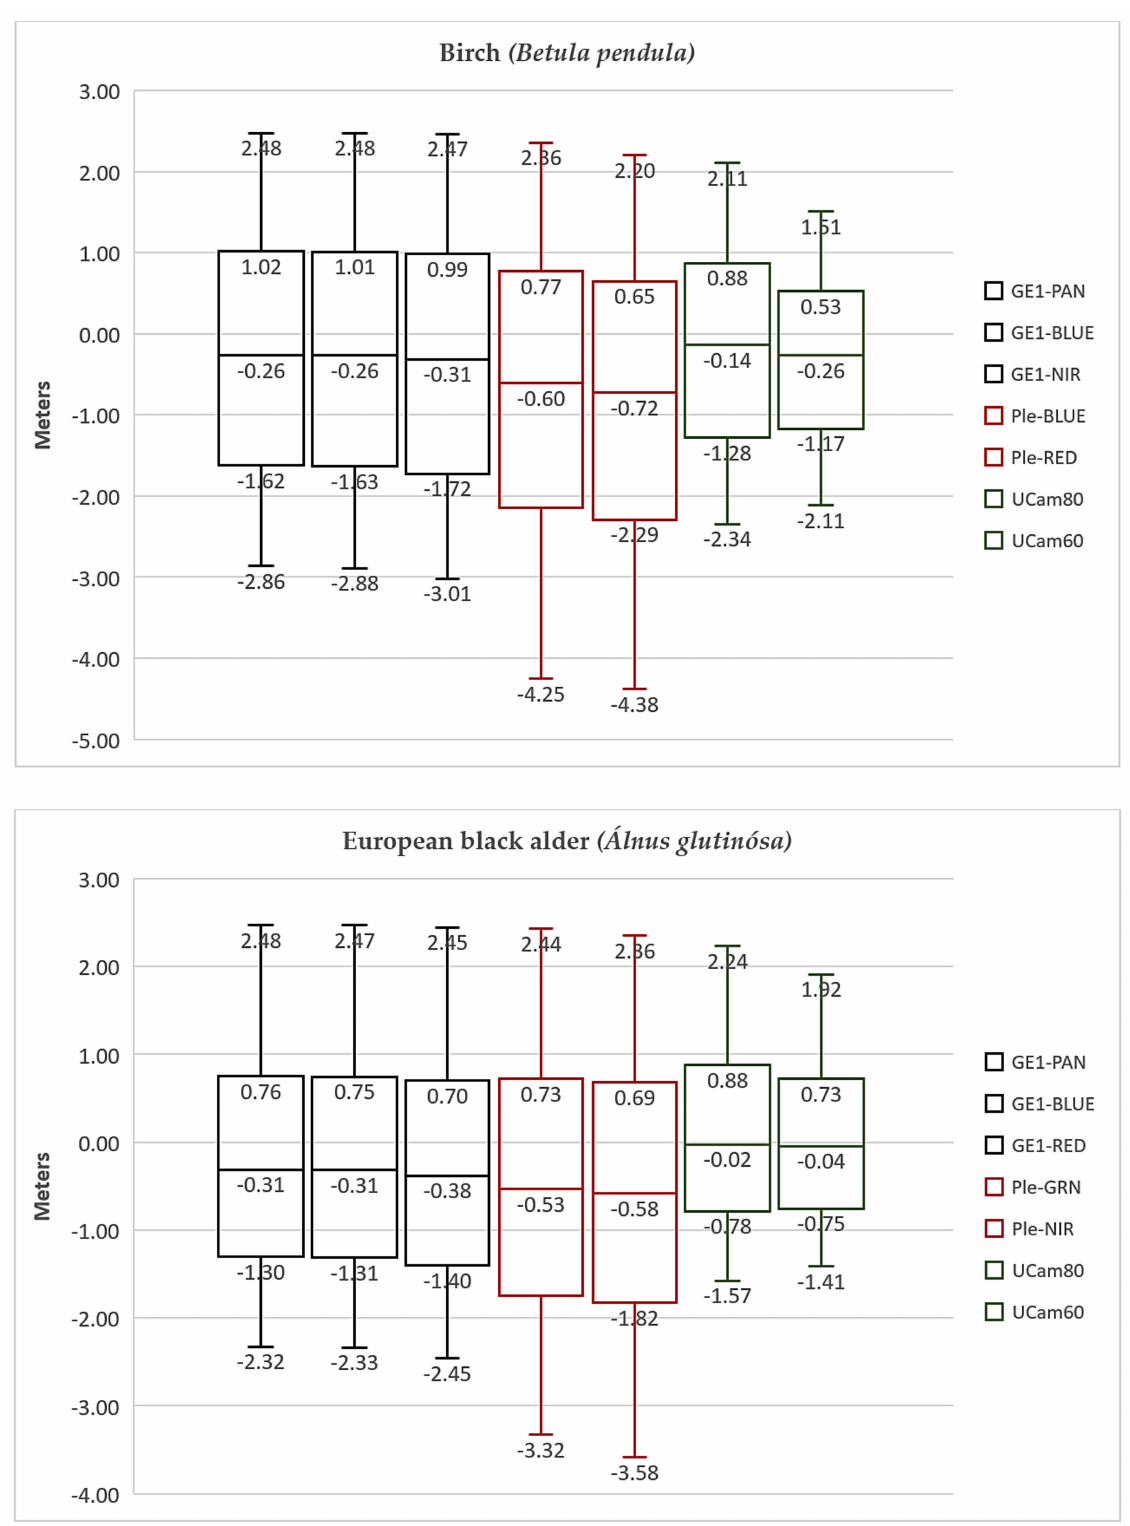
Figure 6. The accuracy box plots represent differences between image-derived DSMs heights and corresponding LiDAR individual canopy peaks in selected models (X-axis) and separated by four main vegetation species, where: vertical boxes represent the errors range (Y-axis, meters) between the lower (Q 1 = 25%) and higher (Q 3 = 75%) quartiles; the lower/higher whiskers are 10% and 90% percentiles; the horizontal line in the box is the median error (50%); GE1 = GeoEye1 ; Ple = Pleiades ; UCam— UltraCam (80% and 60% overlap) based models with sensor band